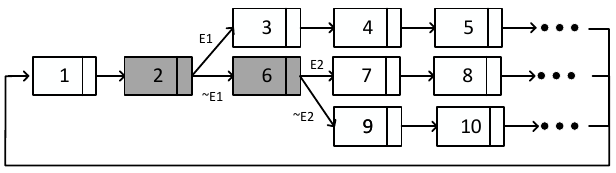
Figure 9. Linked-List Multi-schedule Graph